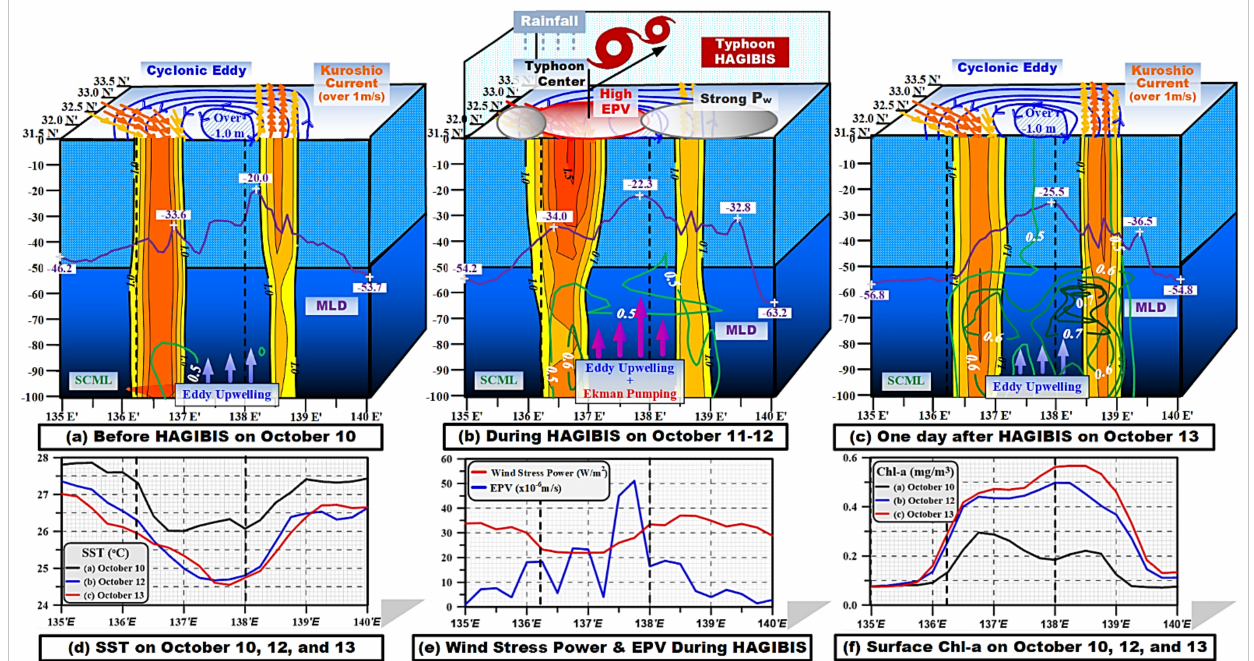
Figure 11. Quantitative conceptual diagram of ocean variability from 100 m depth to the sea surface; ( a ) before, ( b ) during, and ( c ) a day after HAGIBIS; Northwest Pacific Ocean zonal transect (latitude 31.5 ◦ N; longitude 135 ◦ –140 ◦ E) including cyclonic eddy area [blue isolines; ( a – c ) in the sea surface], the Kuroshio current depicted by integrated horizontal velocities on different depths with red; over 1.5 m/s, orange; 1.0 < V < 1.5 m/s, and yellow; over 1.0 m/s, and typhoon HAGIBIS represented by the affected area where strong P w (gray circles) and high EPV (red circle) at ( b ) in the sea surface. The subsurface layers comprise the MLD (Violet), HSC (light green; 0.5 mg/m 3 ) , and SCML (deep green; above 0.7 mg/m 3 ). The three graphs indicate ( e ) P w (W/m 2 ) and EPV ( × 10 − 6 m/s) on the center panel during HAGIBIS, ( d ) sea surface temperature ( ◦ C) on the left panel, and ( f ) concentration of surface Chl-a (mg/m 3 ) on the right panel before, during, and a day after. Two vertical dashed lines marked on both the main plot and the subplot indicate the region with the strongest typhoon effect along the typhoon’s center (longitude 136.5 ◦ –138 ◦